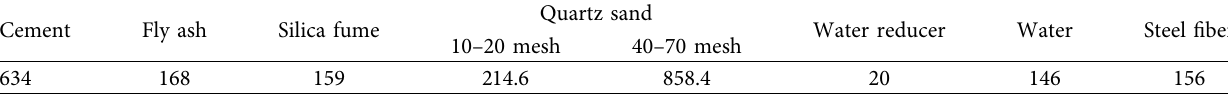
Table 1: Mix proportion of UHPC (unit: kg/m 3 ).